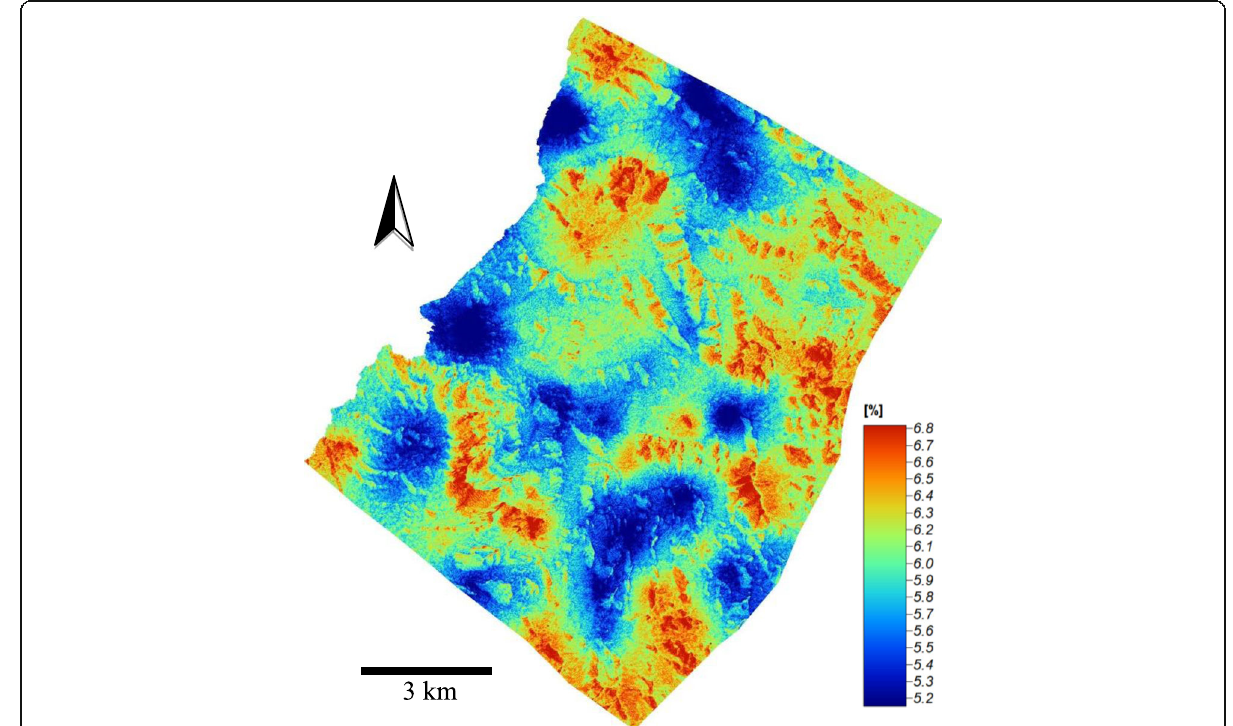
Fig. 11 Final Model of Transformed Silt by UK with predictors by backward elimination method and exponential variogram